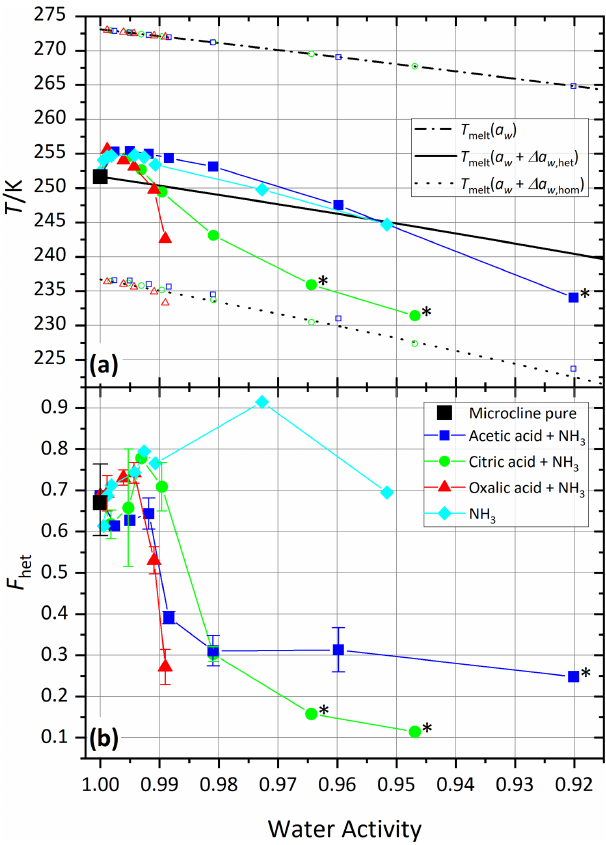
Figure 4. Compiled freezing experiment results of microcline (2wt%) in neutralized aqueous carboxylic acid solutions of varying concentration. Cyan diamonds for NH 3 solutions are from Kumar et al. (2018). Data points and curves are as explained in Fig. 3.